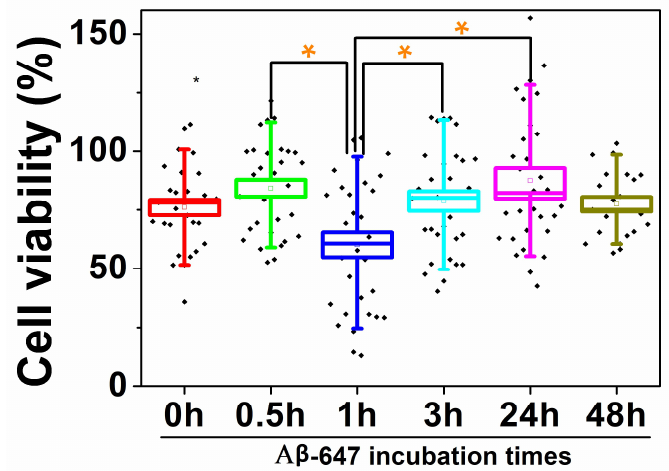
Figure 7. Box and whisker plot representing N2a cell viability upon the addition of A β -647 aggregates incubated for different times, expressed as the percentage of cell viability when compared with that in the control cells in the absence of aggregates. Boxes represent the standard error of the mean, and whiskers represent 90% of the results. Orange asterisks indicate populations that are significantly different from each other, with a 95% confidence interval.